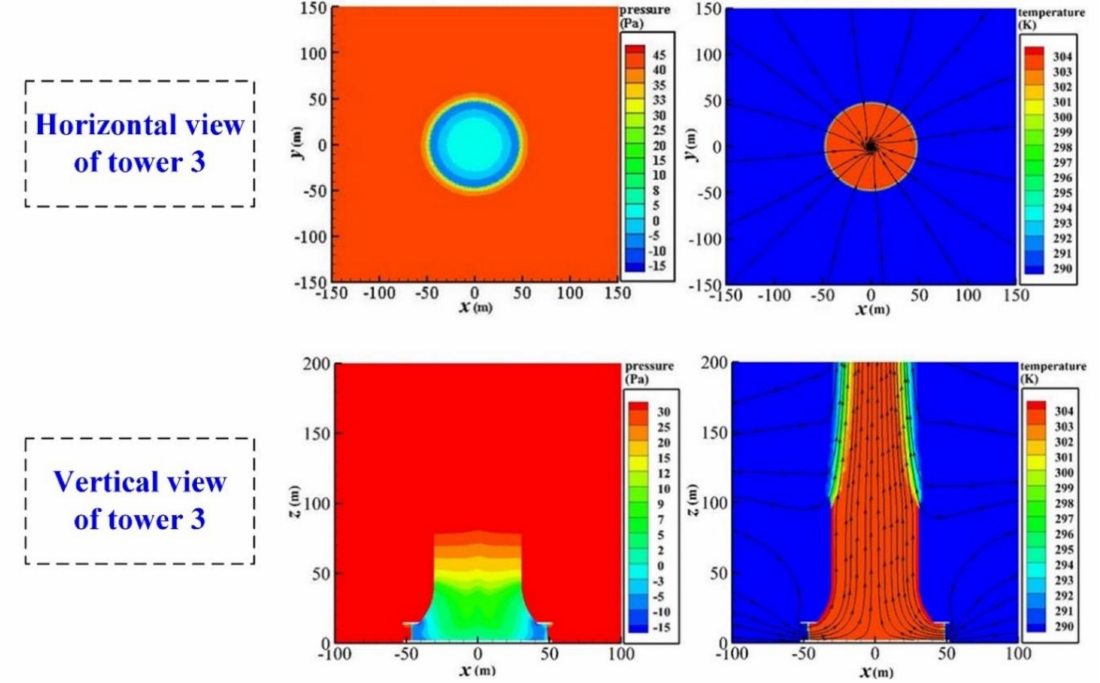
Figure 8. Air variable contours for steel-truss NDDCS with hyperbolic/cylindrical tower configuration without ambient